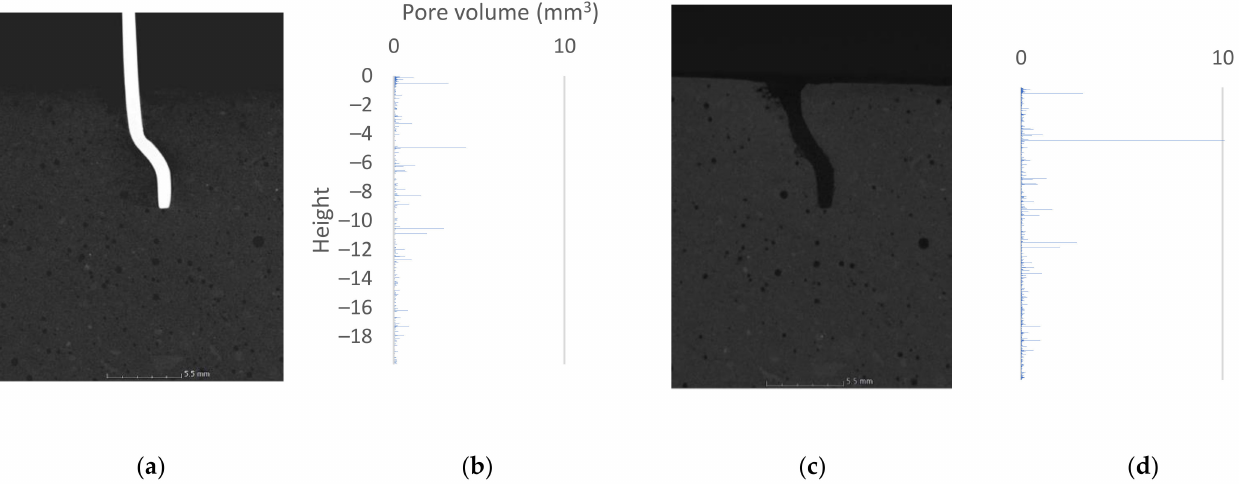
Figure 6. The 10 mm sample: ( a ) 2D cross-section before fiber pullout; ( b ) 3D porosity analysis—plot of pore volume against height in sample before fiber pullout; ( c ) 2D cross-section after fiber pullout; ( d ) 3D porosity analysis—plot of pore volume against height in sample after fiber pullout.